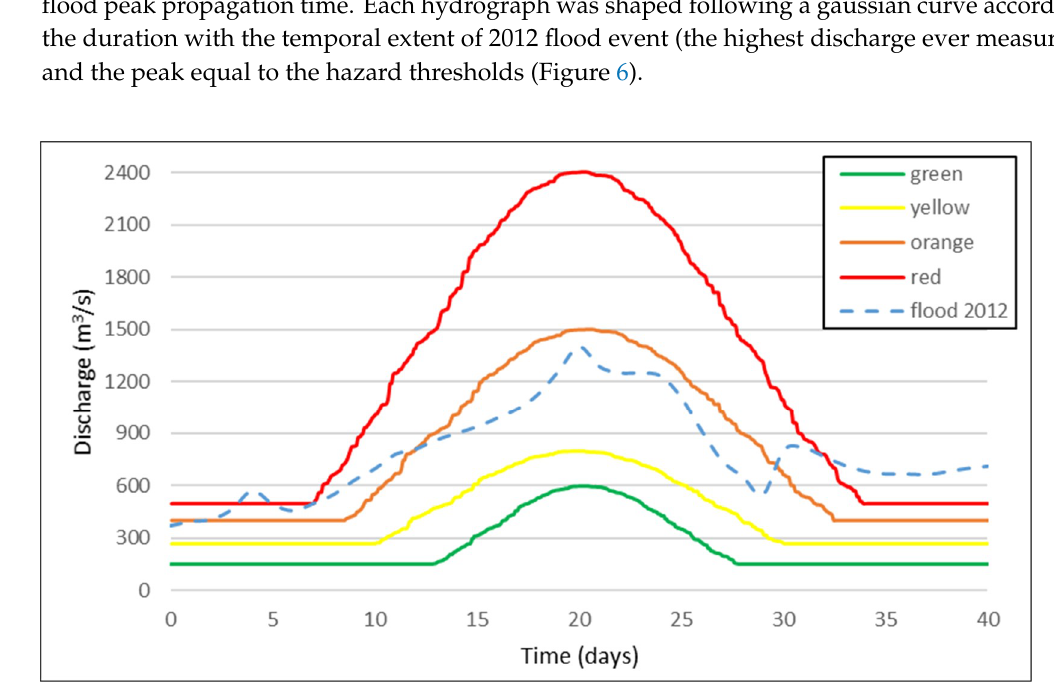
Figure 6. Artificial hydrographs used in the unsteady flow simulations for the flood propagation time for the four hazard scenarios and the hydrograph of the 2012 flood event.